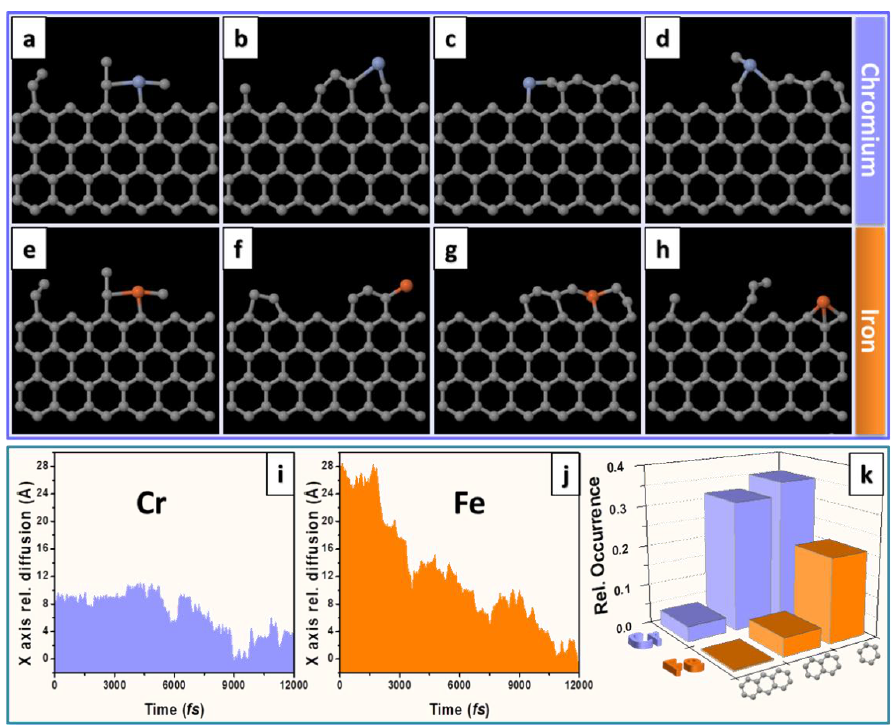
Figure 6. Stick and ball models from molecular dynamics ( MD) simulations for a Cr atom ( a – d ) and Fe atom ( e – h ) at a graphene edge showing catalytic growth of graphene. Comparison of the diffusion activity of Cr and Fe atoms at graphene edge ( i , j ) and relative occurrence of new hexagon formation at the graphene edge ( k ). Reproduced with permission from Ref. [46] Copyright (2017), Tsinghua University Press and Springer-Verlag GmbH Germany.